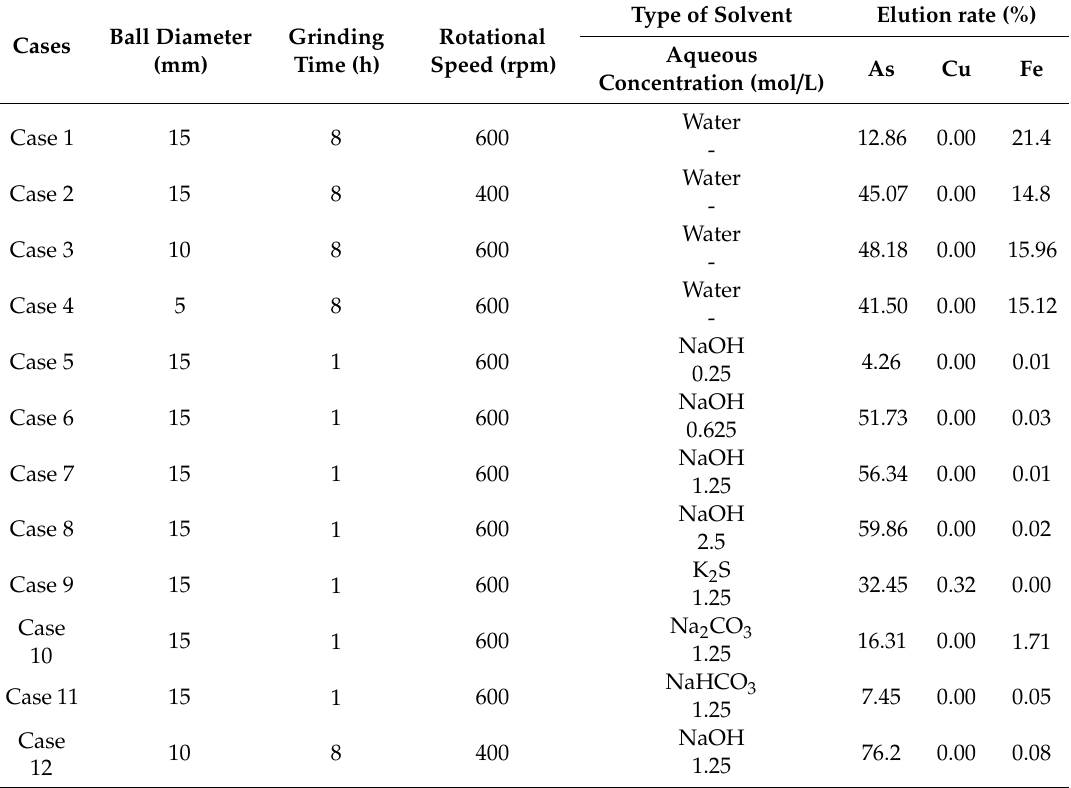
Table 2. Summary of the optimization of grinding conditions. The elution rate of As, Cu and Fe from combined ground samples using di ff erent ball diameters, grinding times, rotational speeds, andtype and concentration of solvent.